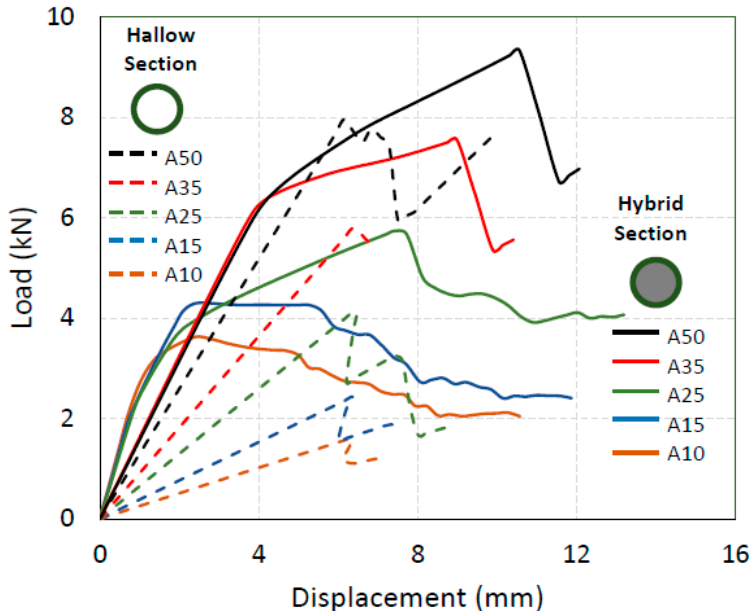
Figure 7. Load-deflection plot of areal change in tubular beams.